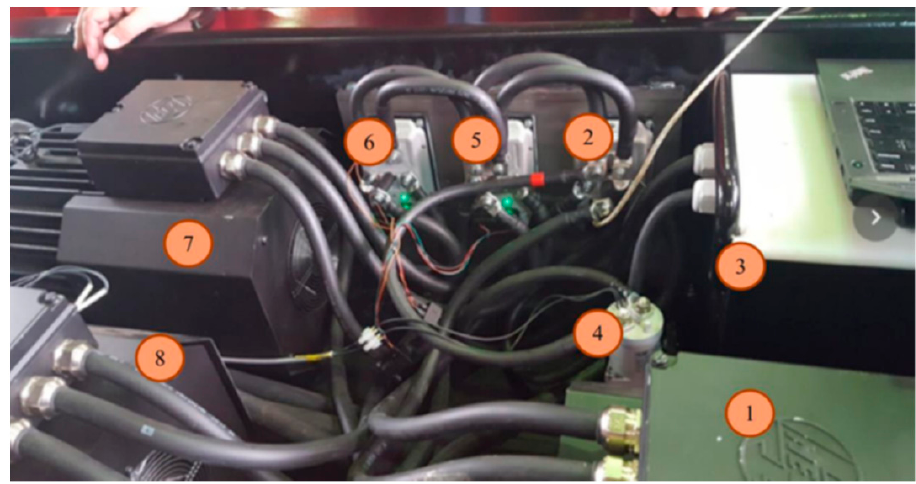
Figure 3. Layout of the electric drive components in the trailer chassis. 1, 7, 8—induction machine; 2, 5, 6—three phase DC/AC inverters; 3—battery; 4—circuit breaker (author: Petr Procházka). Table 1. Working cycles of the tractor-trailer unit travelling on an unpaved surface. Working Cycle